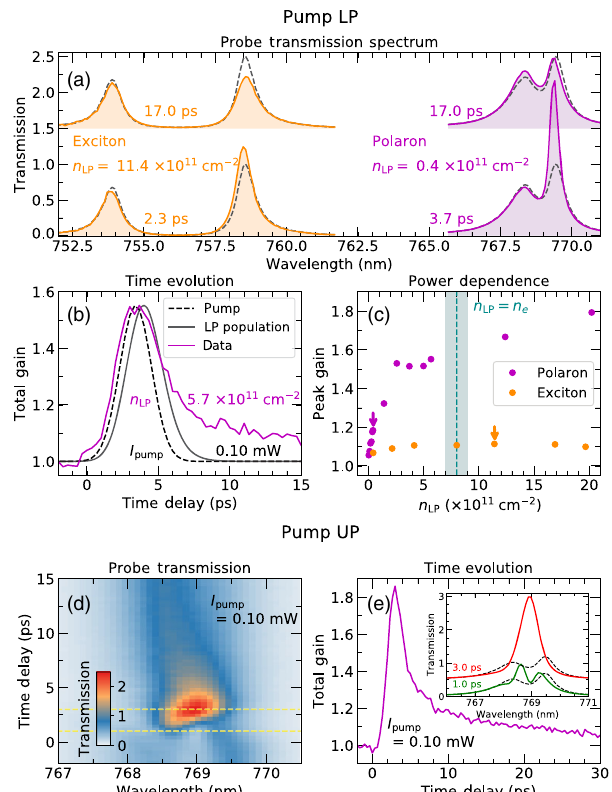
FIG. 3. Polariton amplification observed in transmission. (a) Solid lines show the probe transmission spectrum under resonant pumping of the exciton lower-polariton and polaron-LP at different time delays τ . Dashed lines show the average τ < 0 probe transmission spectrum obtained by taking the mean of the transmitted signal at a given wavelength over 5 different negative time delay values. (b) Evolution of the total gain for polaron-LP as a function of τ . Gain for a given τ is calculated by dividing the integrated transmission under both UP and LP branches by the average integral taken at τ < 0 . Black dashed line indicates the arrival of the pump pulse as determined in an independent measurement (see Appendix B). Black solid line shows the expected time evolution of the coherent LP population injected by the pump. (c) Dependence of the peak gain on the density of LPs injected by the pump. Blue shaded area indicates the regime where polariton density and electron density are comparable in the system. (d) Time delay scan of the probe transmission spectrum for resonant pumping of the polaron-UP. (e) Time evolution of integrated gain corresponding to (d). Inset: The probe transmission spectrum at τ ¼ 1 and 3 ps indicated by yellow dashed lines in